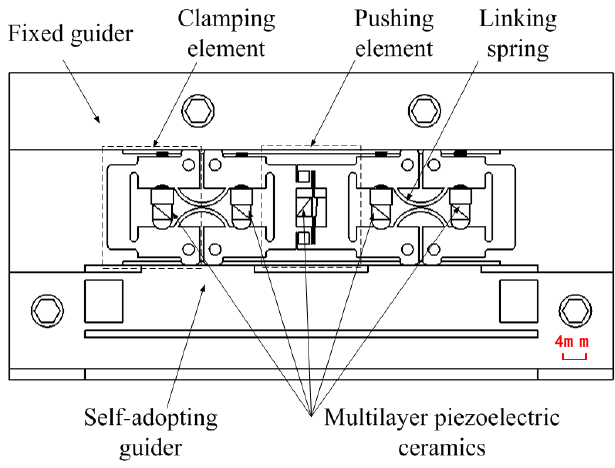
Figure 6. Structure of advanced inchworm piezoelectric motor. Table 1. Performance of multilayer piezoelectric ceramics PL055.30.